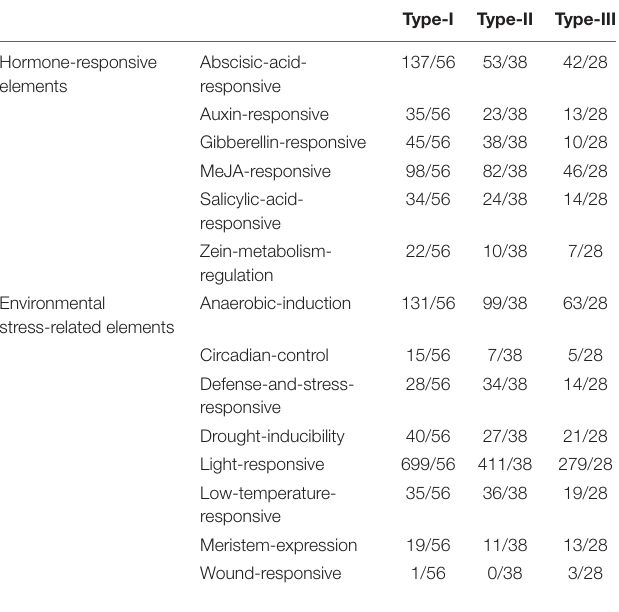
TABLE 2 | The cis -acting elements on the BnaAHLs